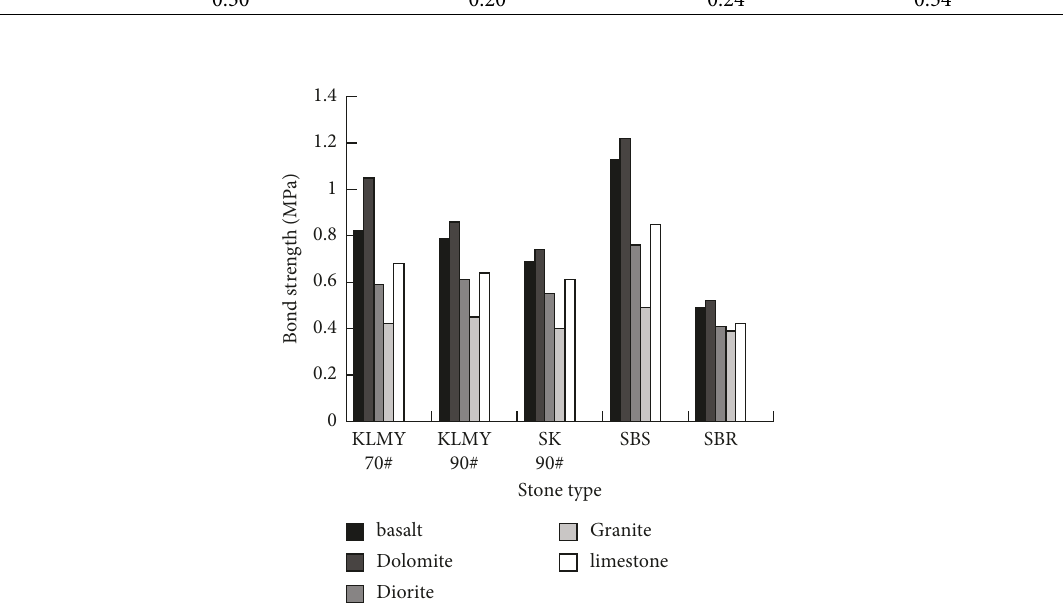
Figure 7: Ratio of two groups of